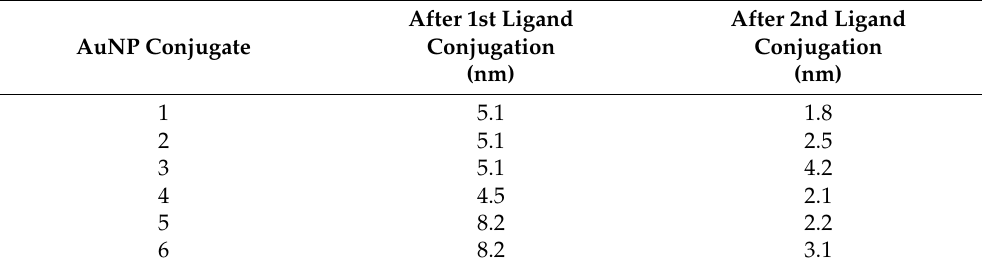
Table 2. Increase in hydrodynamic diameters of gold nanoparticle conjugates during the sequential conjugation determined by DLS